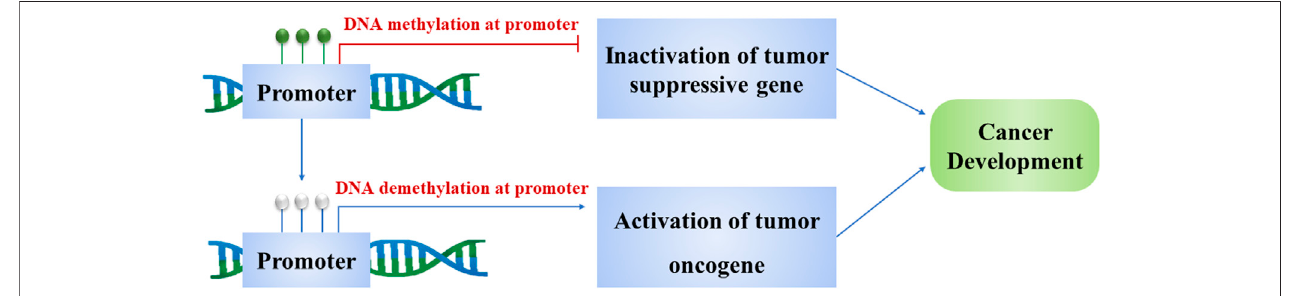
FIGURE1| Methylationanddemethylationofthegenepromoterturnontumorigenesis.Methylationofpromotersinactivatestumorsuppressorgenesandinduces cancer development. Demethylation of promoters activates oncogenes and results in the cancer cell proliferation.